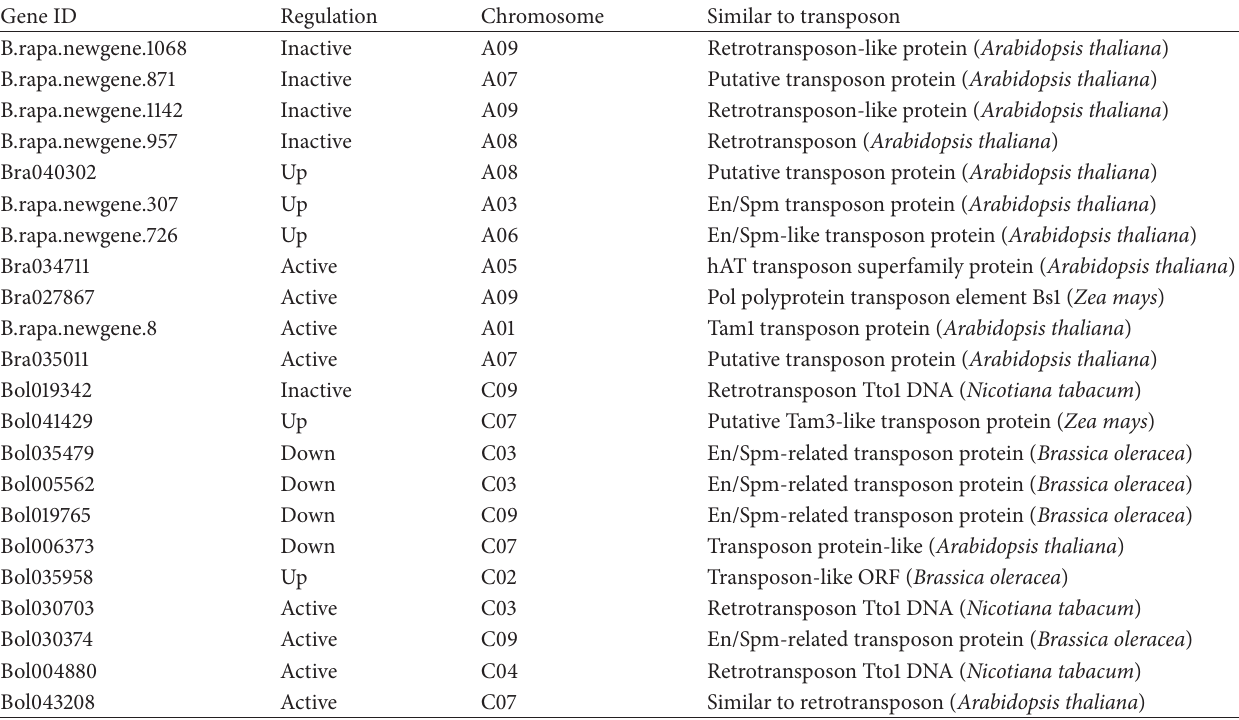
Table 3: The differential expressed transposon-like genes in hybrid F 1 .